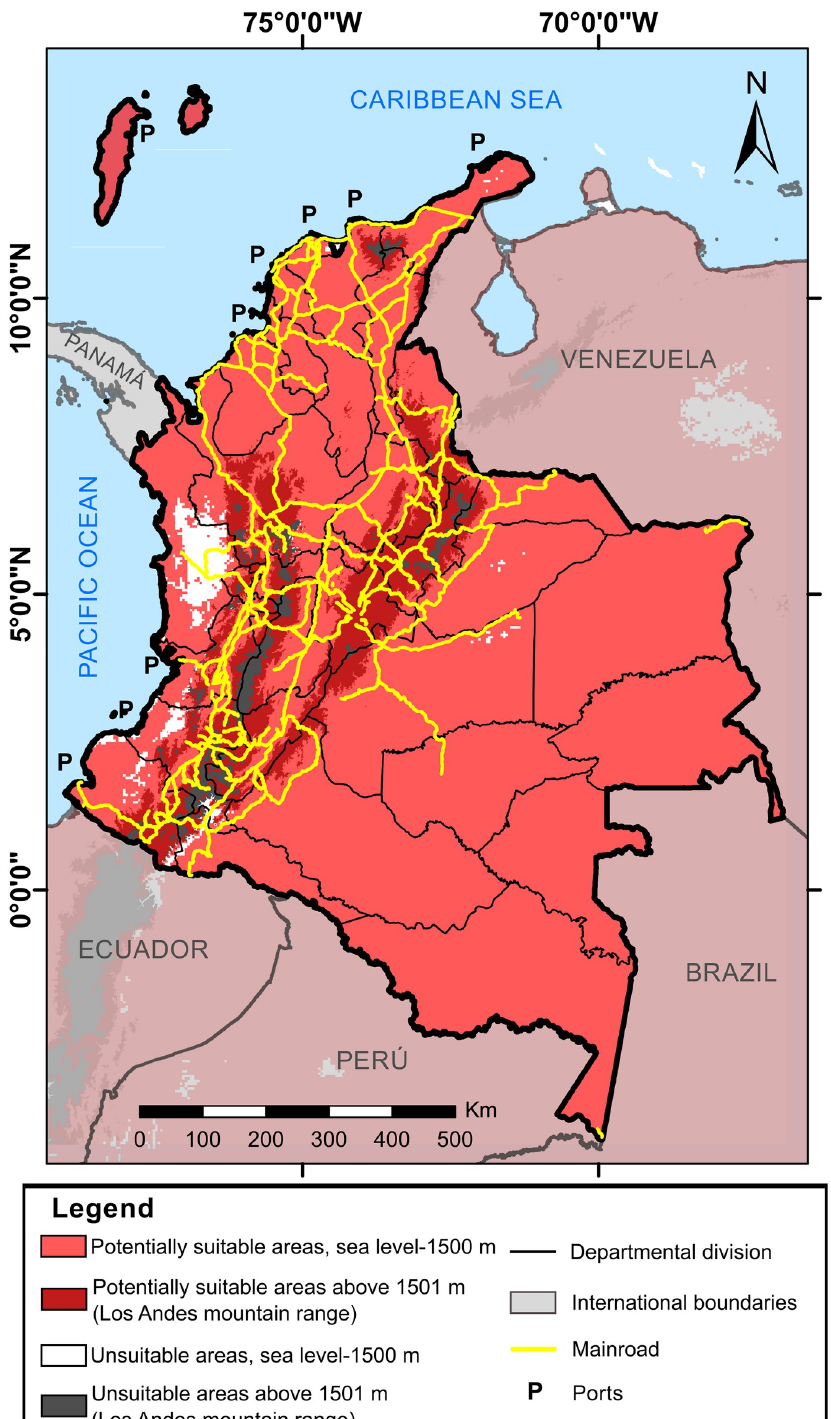
Fig 2. Potentially suitable areas to distribution of A . albopictus under current conditions in Colombia. The light red corresponds to binary threshold. The map was built using the free and open source QGIS software version 3.10.11 (https://www.qgis.org/en/site/about/index.html) and shapefiles were obtained from the free and open source DIVA-GIS site (https://www.diva-gis.org/gdata).